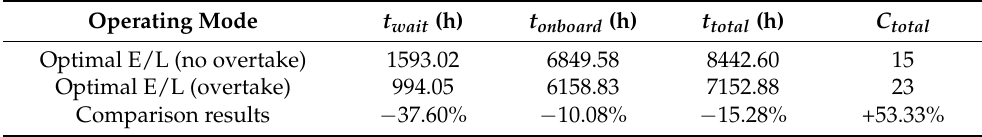
Table 8. Comparison of the results for E/L mode with the overtaking condition and E/L mode without the overtaking